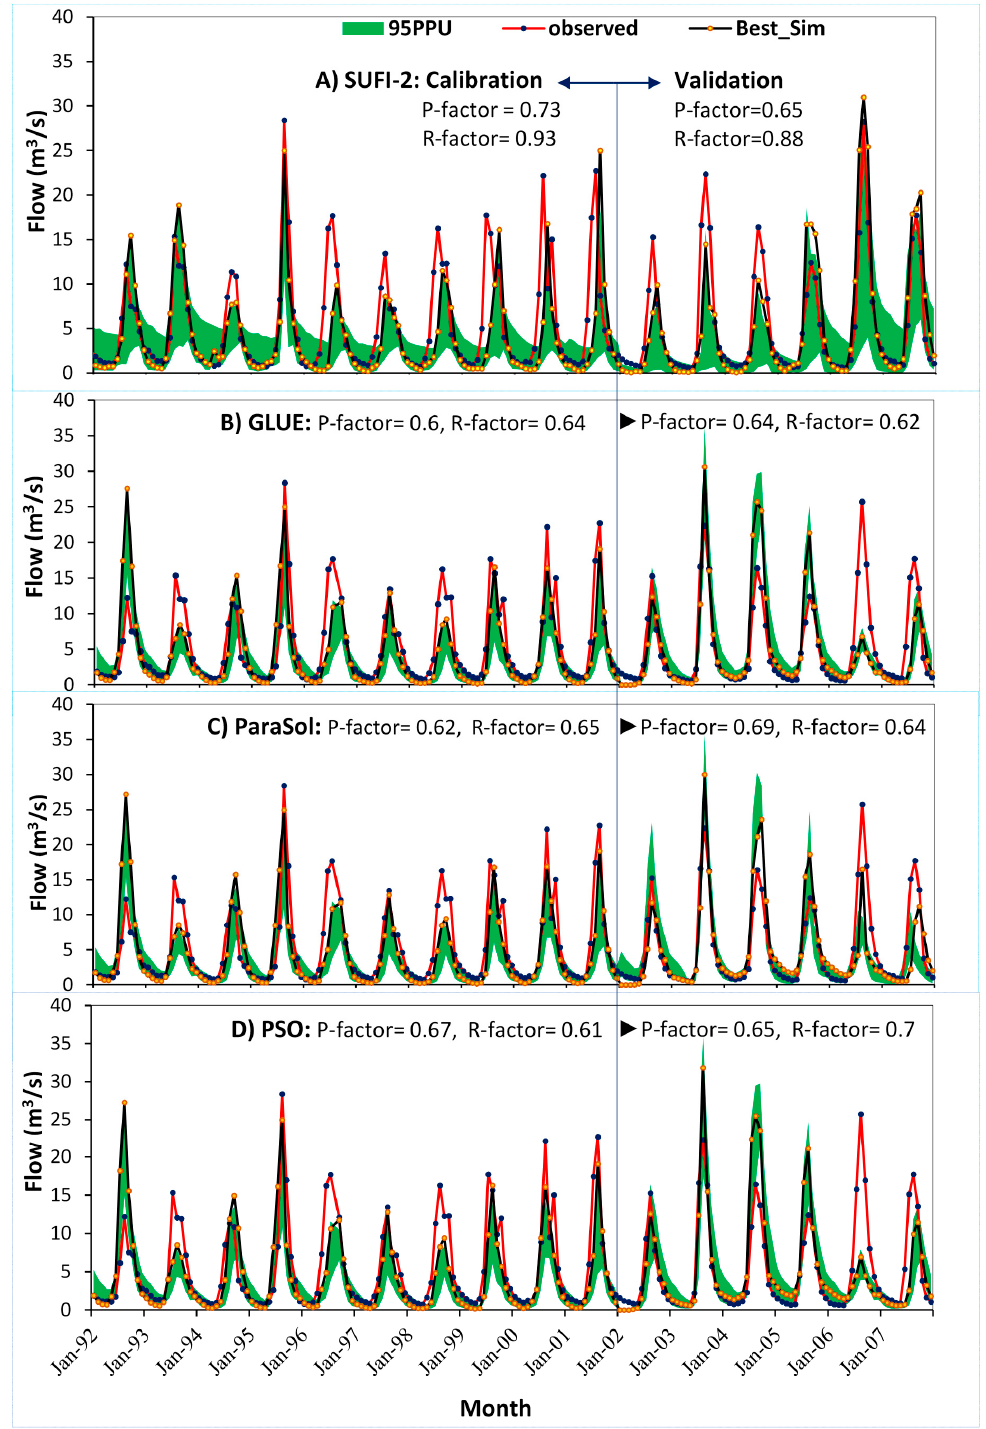
Figure 8. Monthly observed flow, 95% model uncertainty, and best estimates for calibration (1992–2001) and validation (2002–2007): SUFI-2 ( A ), GLUE ( B ), ParaSol ( C ), and PSO ( D ).